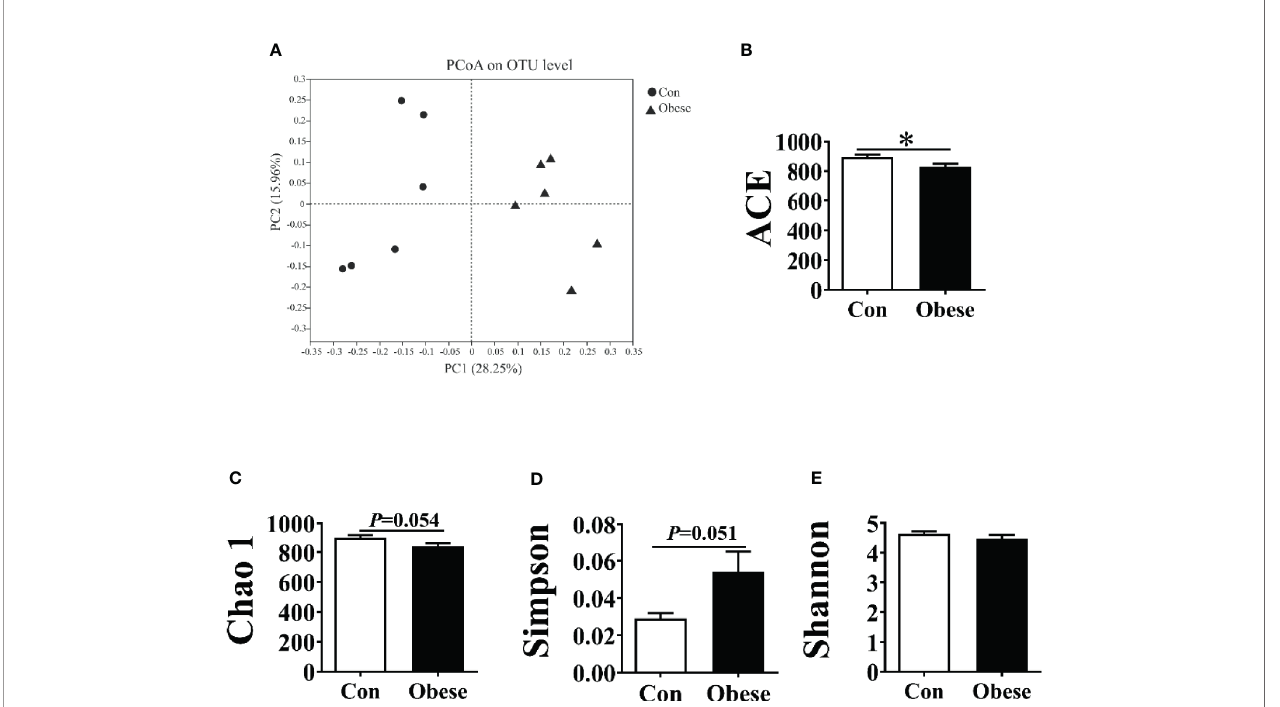
FIGURE 6 | Alpha and beta diversities for the fecal microbiota community. (A) Principal coordinates analysis (PCoA, Bray – Curtis distance) plot of the fecal microbial community structure. (B – E) . The microbiota a diversity was estimated by ACE, Chao 1, Simpson, and Shannon index. “ * ” indicates statistically signi fi cant differences (P <